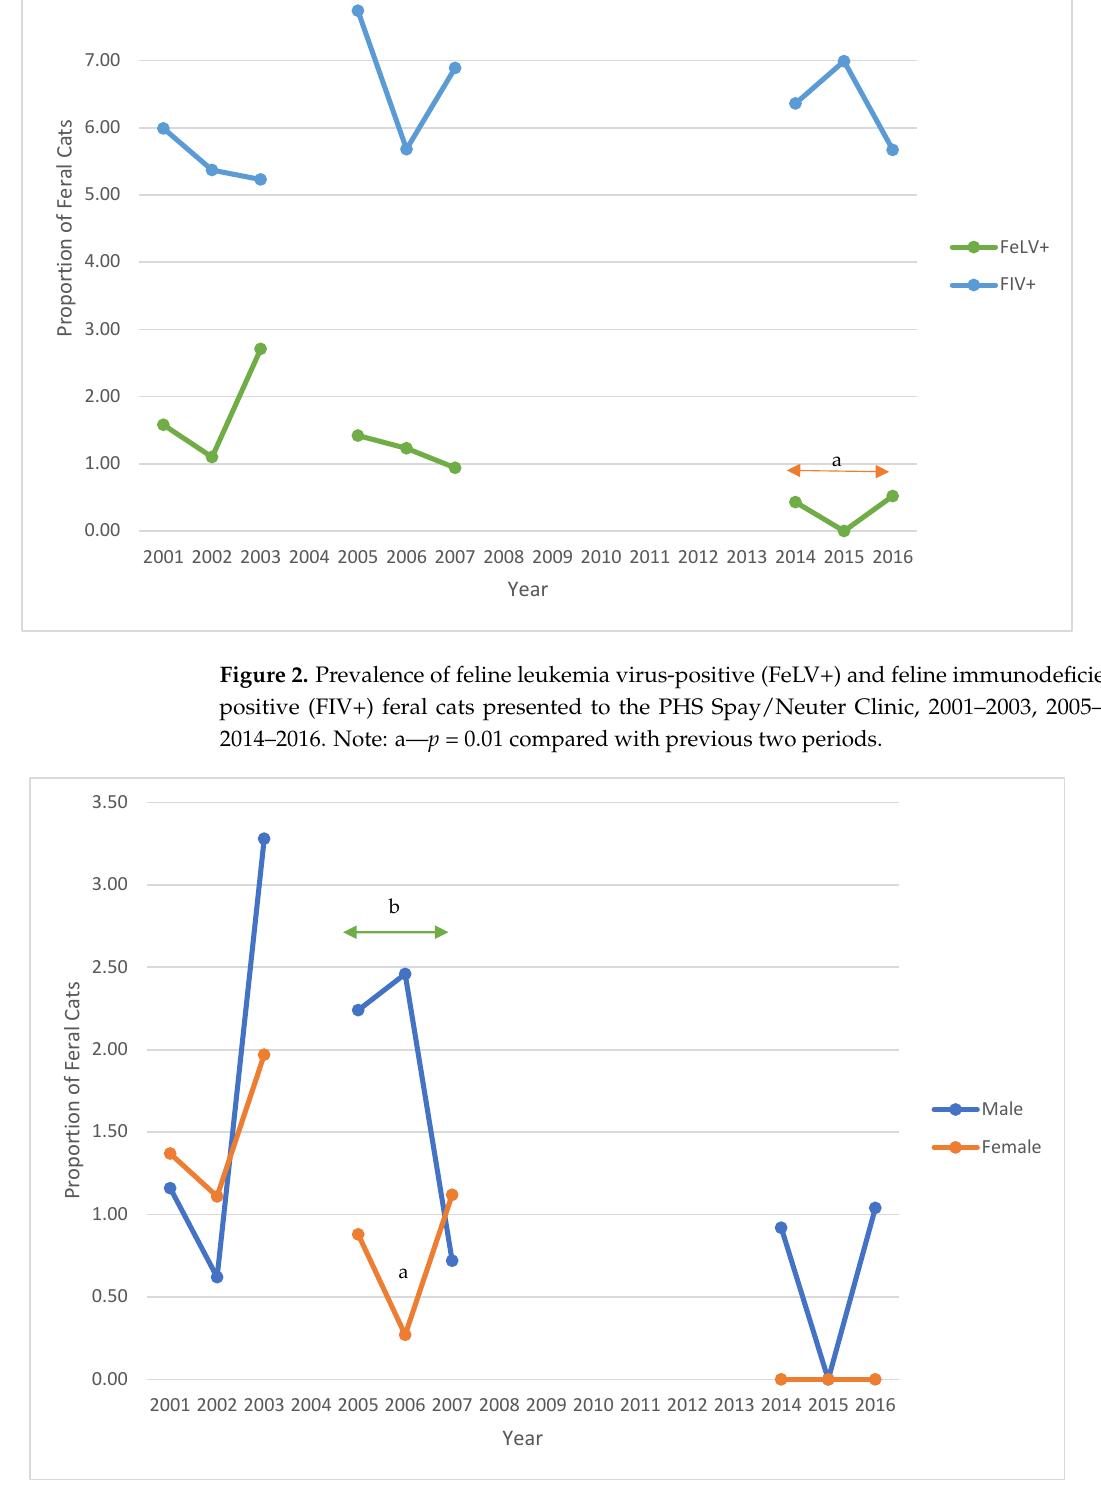
Figure 3. Prevalence of feline leukemia virus-positive feral cats, stratified by sex, presented to the PHS Spay/Neuter Clinic, 2001–2003, 2005–2007, and 2014–2016. Notes: a— p = 0.02; b— p = 0.04 across the